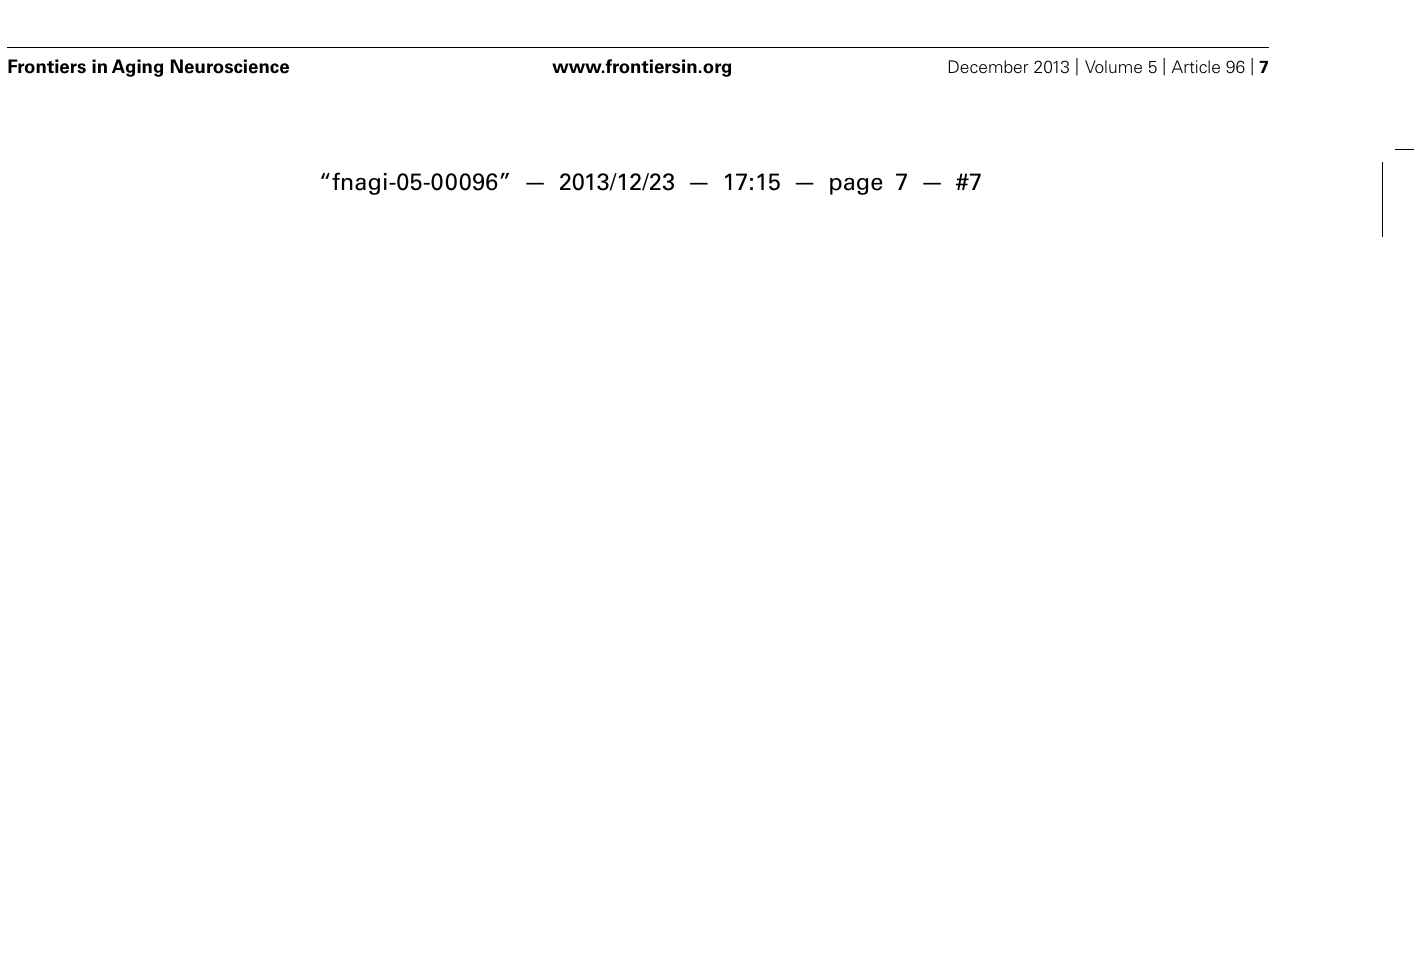
compared with vehicle (unpaired Student’s t test).The mean levels (nanogram per milligram total protein ± SEM, n = 5/group) in the three vehicle-treated groups (protocol 1, 2, and 3, respectively) were: insoluble A β 40 : 483 ± 13, 346 ± 62, and 187 ± 31; insoluble A β 42 : 2006 ± 38; 2190 ± 265, and 1477 ± 322; soluble A β 40 : 7.62 ± 1.52, 3.97 ± 0.81, and 10.75 ± 0.87; soluble A β 42 : 0.44 ± 0.07, 0.82 ± 0.02, and 2.48 ±